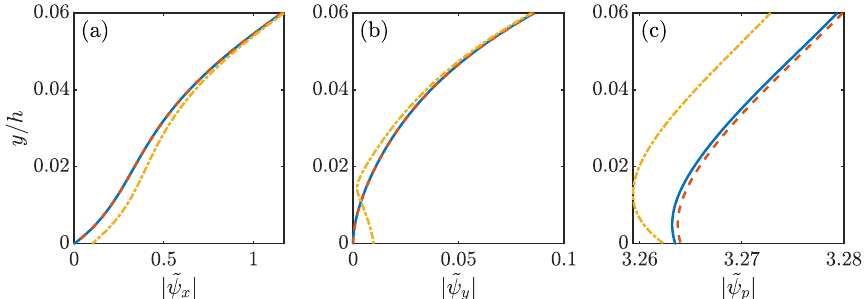
Figure 13. The amplitude of ˜ ψ (blue solid lines), ˜ ψ + ∆ ˜ ψ 1 (red dash lines), and ˜ ψ + ∆ ˜ ψ 2 (yellow dash dot lines) in the near wall region of y / h ≤ 0.06. Subplots from left to right are ( a ) the streamwise response mode | ˜ ψ x | , ( b ) the spanwise response mode | ˜ ψ y | and ( c ) the pressure response mode | ˜ ψ p | . Parameters are Y = 0.003 i , Re τ = 410, ( k x , k z , c + ) = ( 2.78,0,14.08 )